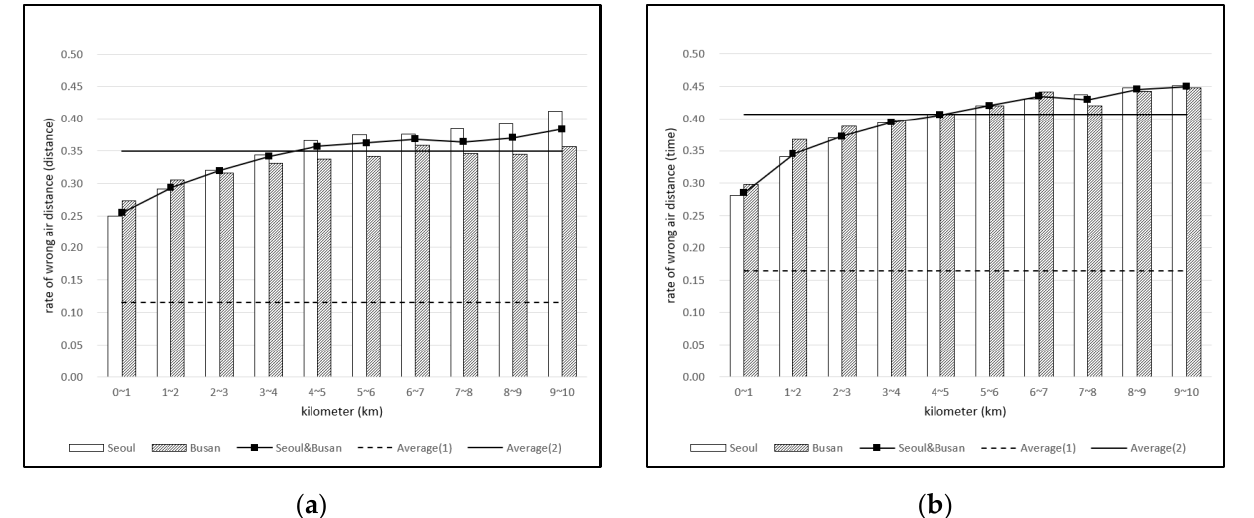
Figure 8. The ratio of closeness deceived by air distance: ( a ) Road distance; ( b ) road time.